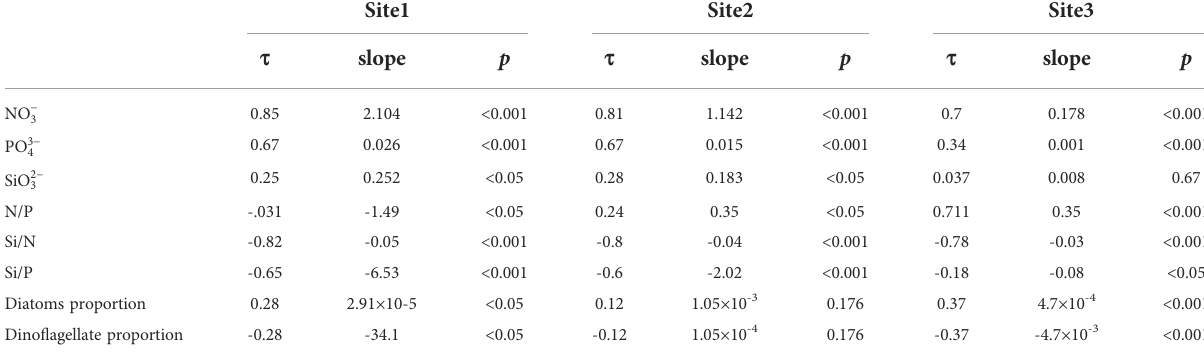
TABLE 2 Mann-Kendall test of nutrients and phytoplankton at three